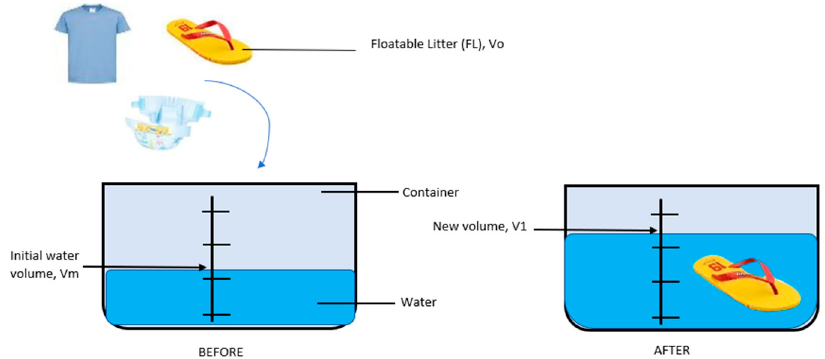
Figure 2. Water displacement method. Source: Author.